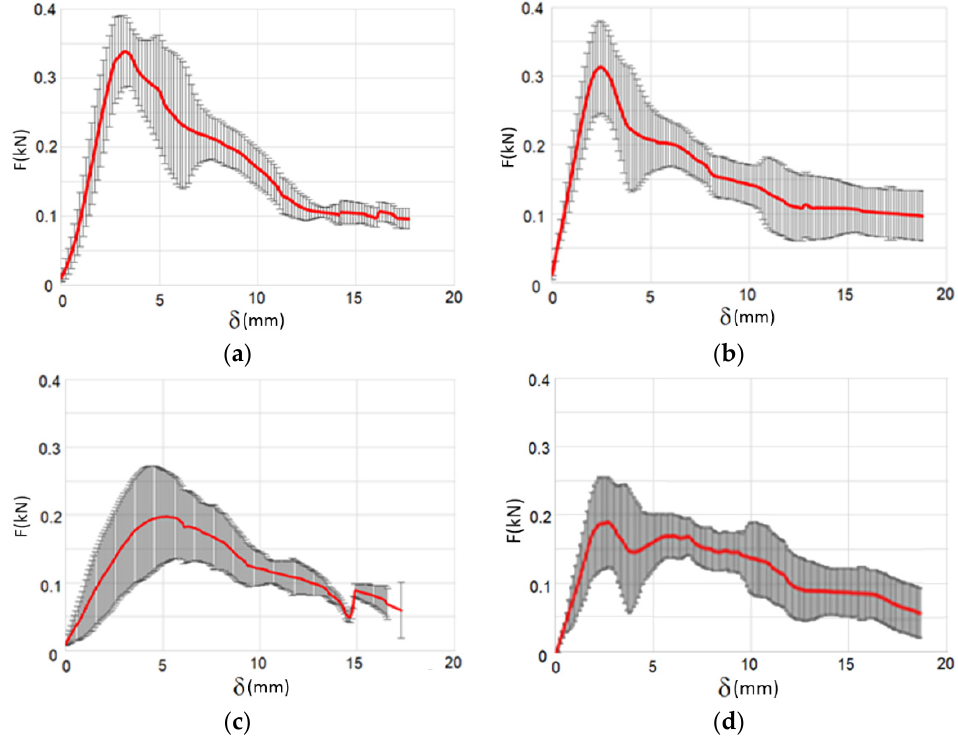
Figure 19. Results of the comparative tests of the tearing off of the shield from the leading edge: ( a ) Factory-bonded sample without aging; ( b ) Factory-bonded sample after aging; ( c ) DP490 bonding sample without aging; ( d ) DP490 bonding sample after aging.